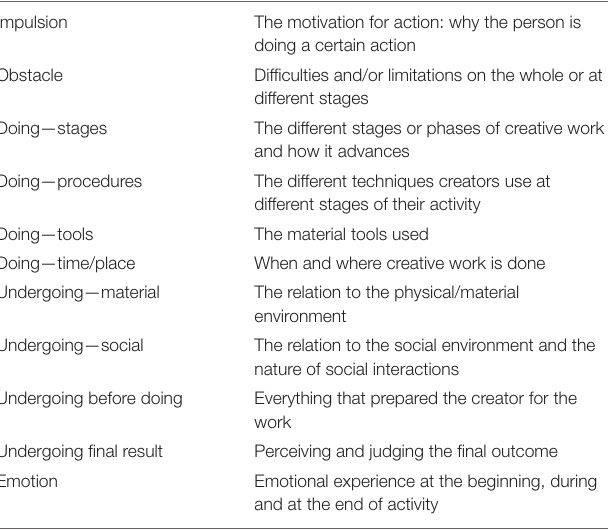
TABLE 2 | Coding frame for comparison of creative action by Glaveanu et al. (2013).